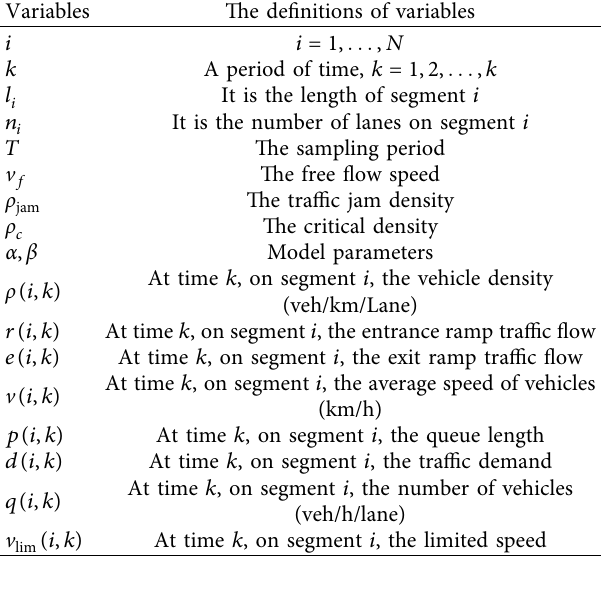
Table 1: Table of definitions of variables.